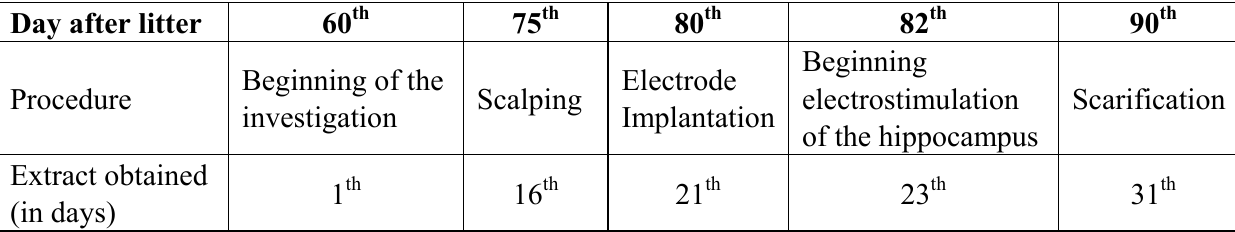
Table 9. Research